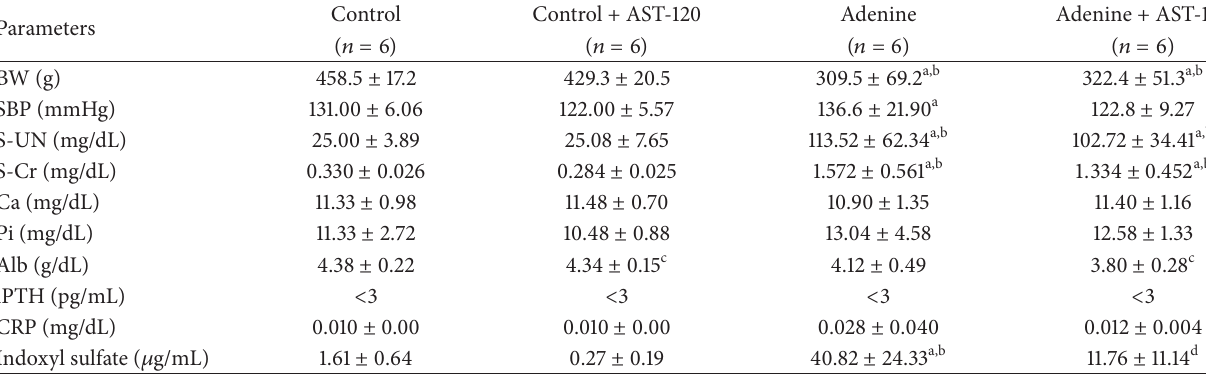
Table 2: Comparison of characteristics and biochemical parameters.